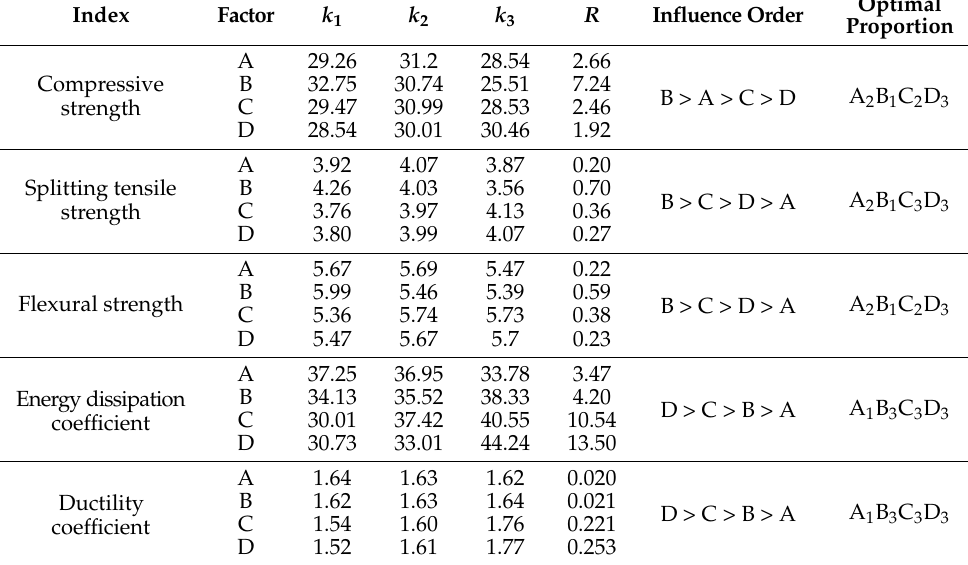
Table 10. Range analysis of the test